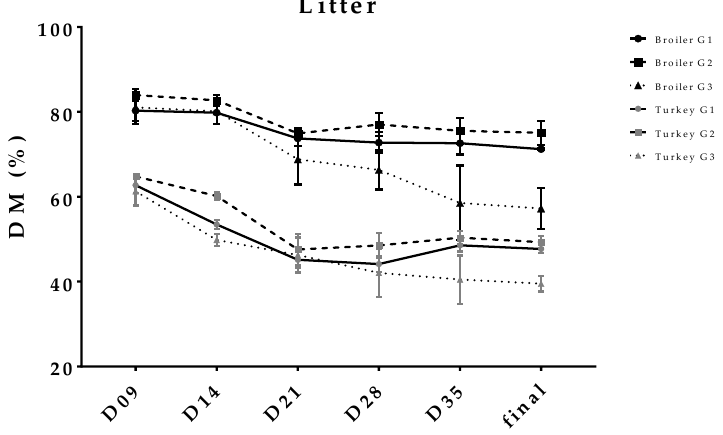
Figure 4. DM content (%) of the litter mixture of excreta in pens with different flooring designs during the experimental period.